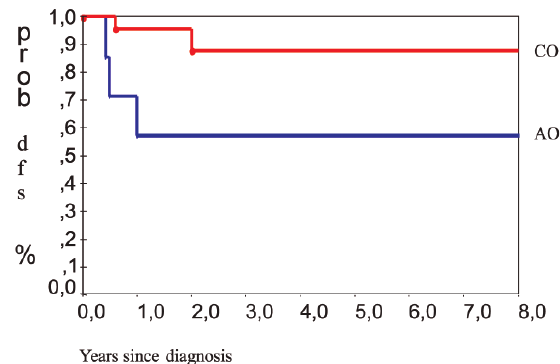
Figure 11 - Kaplan-Meier test for event recurrence, comparing subgroups of osteoblastoma (atypical osteoblastoma and classical